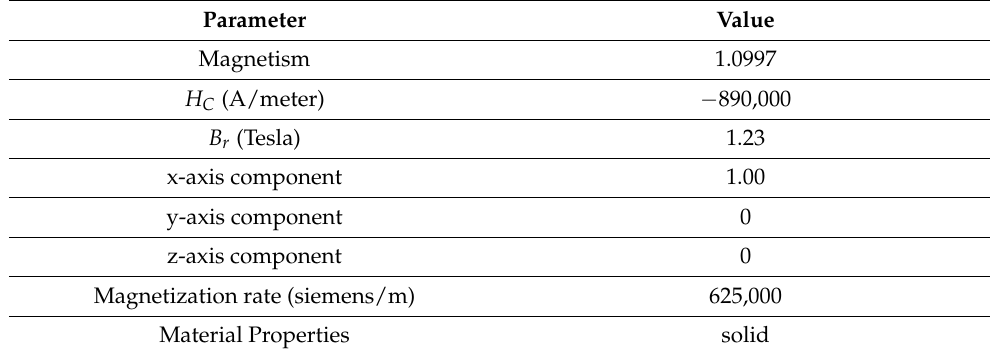
Table 3. Permanent magnet parameter setting table.